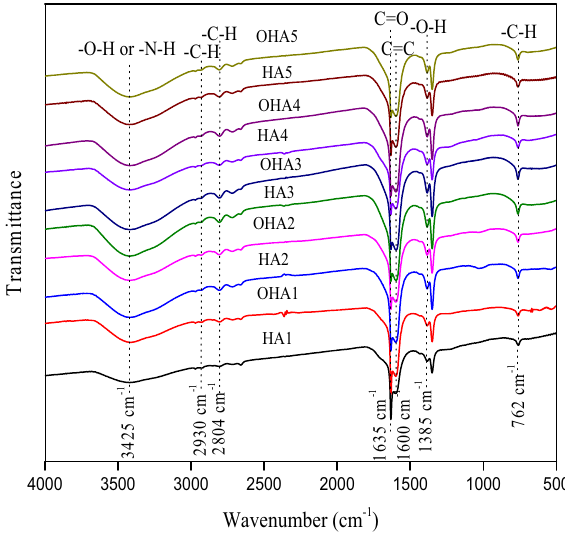
Figure 3. FTIR spectraof HAs. HA1–HA5, the HAs extracted from original coal; OHA1–OHA5, the HAs extracted from oxidized coal.